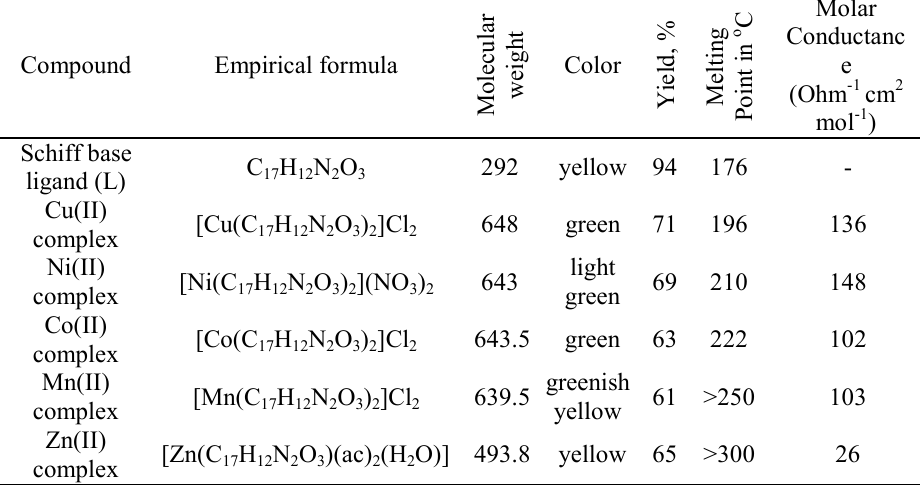
Table 1. Analytical and physical data of schiff base ligand L and its complexes.